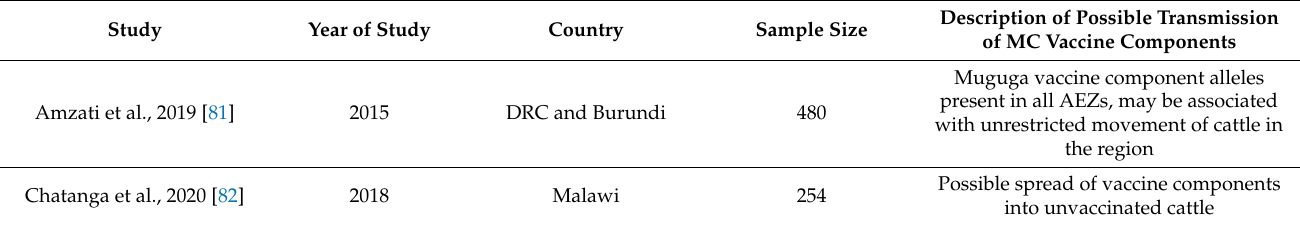
Table 6. Shed and transmission studies. These studies examined or reported the persistence of vaccine strains in vaccinated cattle as well as possible transmission of vaccine strains to unvaccinated